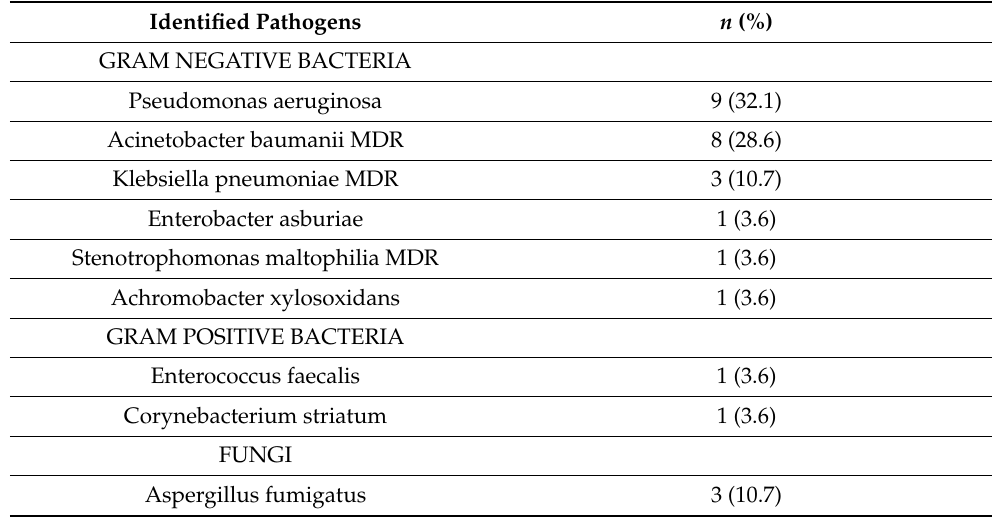
Table 2. A total of 28 pathogens identified in 26 positive microbiological